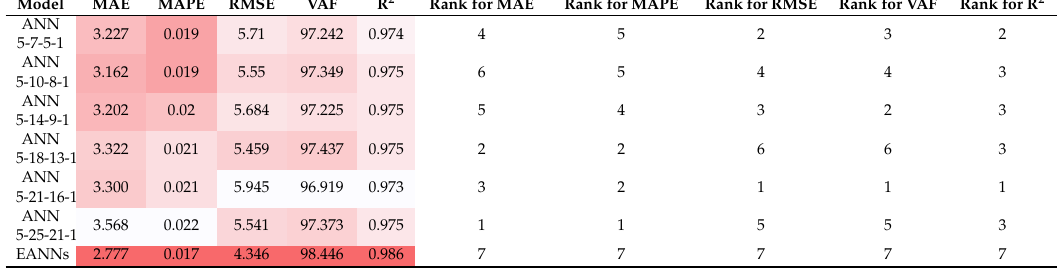
Table 3. Statistical indexes of the models for a set of data in the testing.